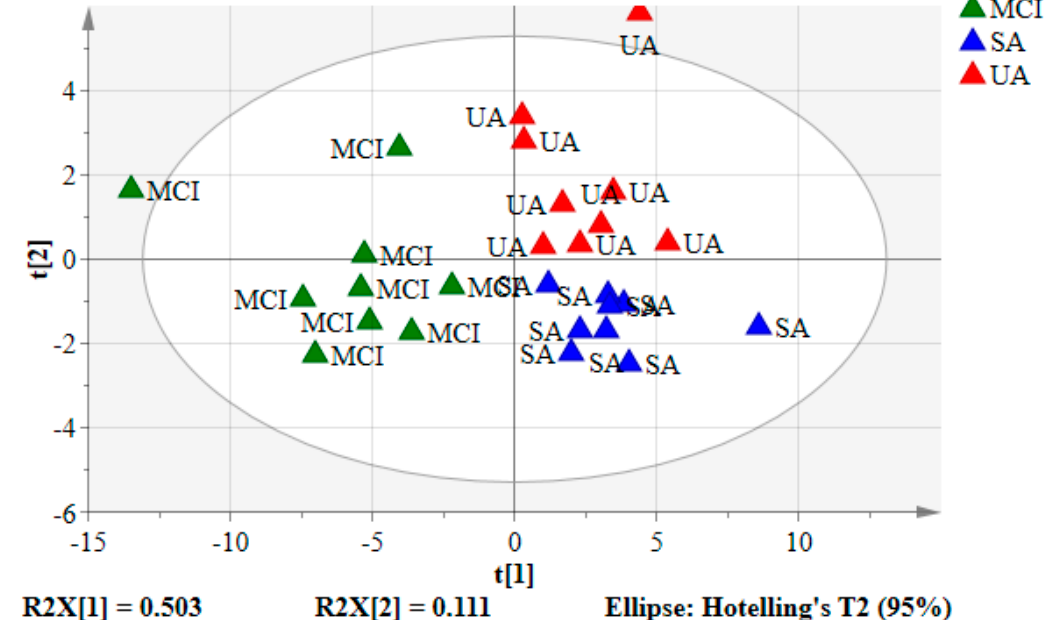
Figure 3. The PLS-DA score plot for SA, UA, and MCI groups. Each point represents 1 H-NMR data of an individual urine sample. Blue triangles: SA, red triangles: UA, and green triangles: MCI.